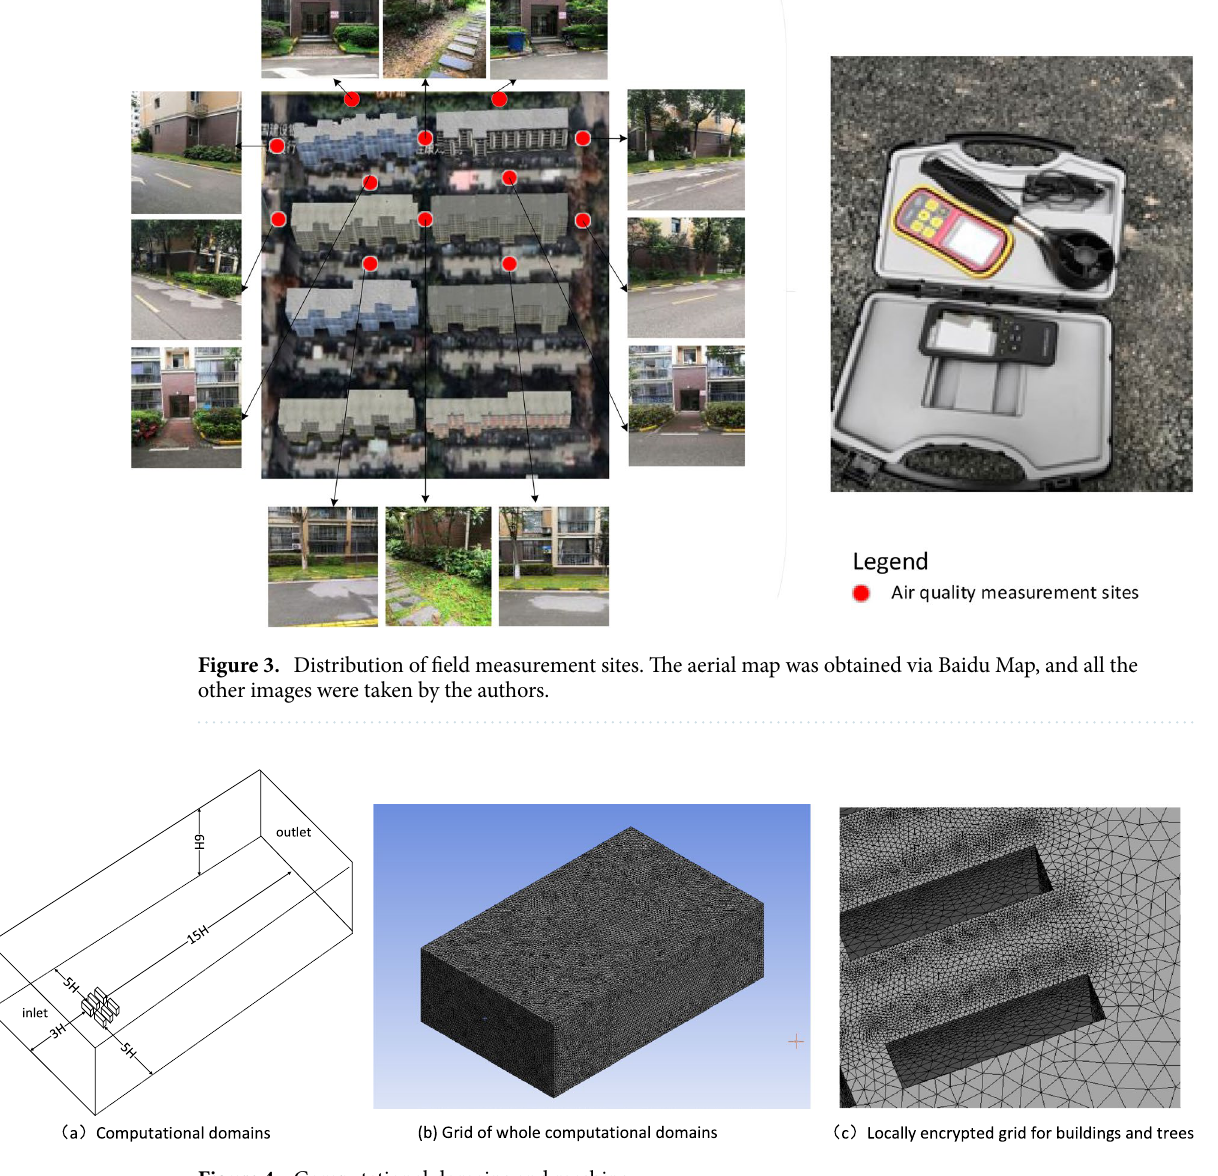
Figure 4. Computational domains and